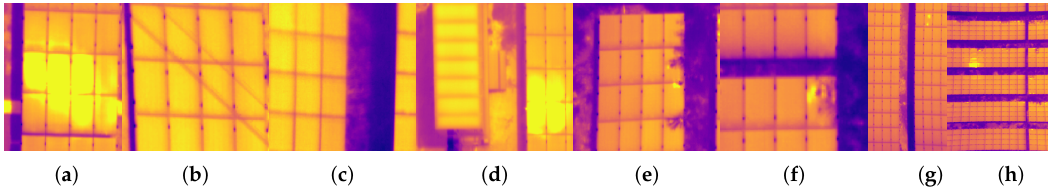
Figure 1. Examples of problems in thermal imaging acquired with drones with complex backgrounds. ( a ) Sunlight reflection. ( b ) Energy lines. ( c ) Poorly defined panel edges. ( d ) Like panel structures. ( e ) weeds shades. ( f ) Edges distortion by hot spots. ( g ) Lens distortion. ( h ) Display of up to 350 panels per